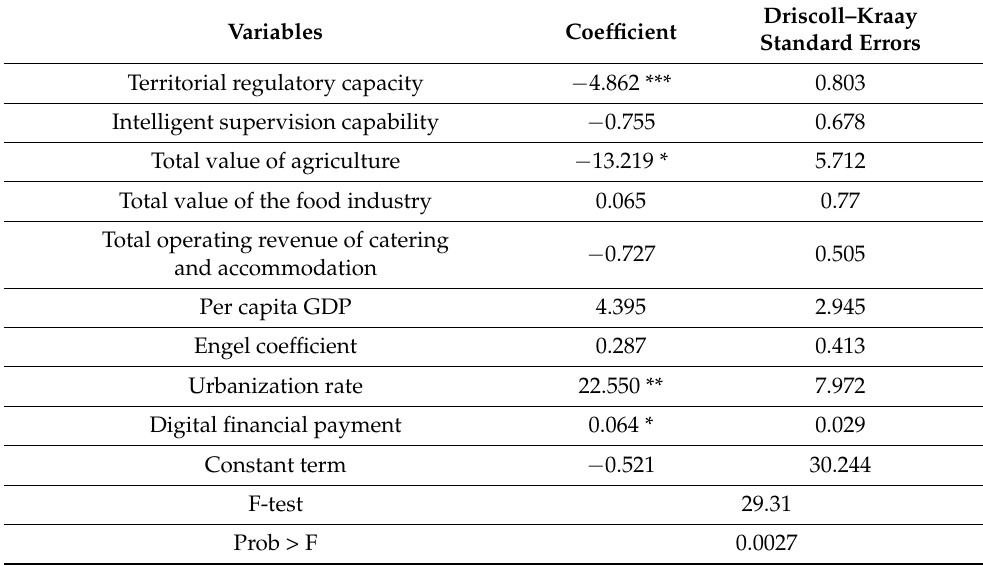
Table 10. Empirical analysis